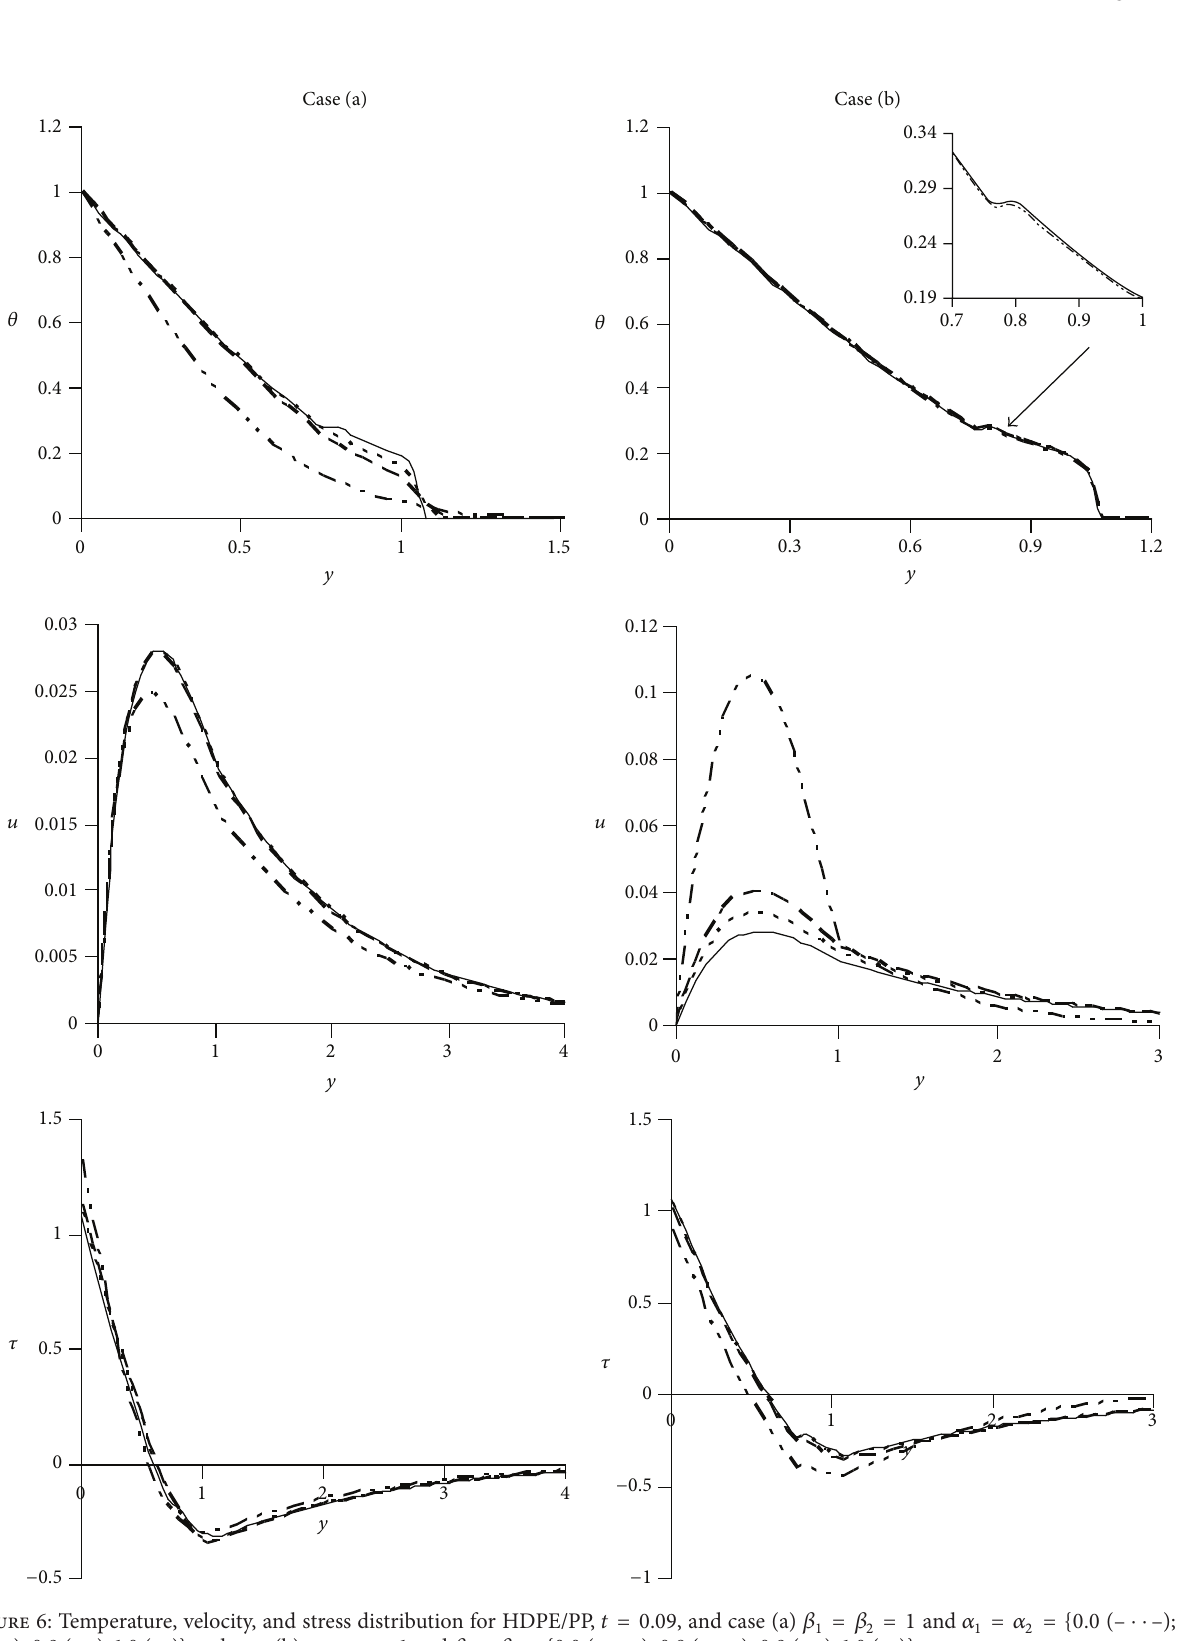
Figure 6: Temperature, velocity, and stress distribution for HDPE/PP, 𝑡 = 0.09 , and case (a) 𝛽 1 = 𝛽 2 = 1 and 𝛼 1 = 𝛼 2 = { 0.0 (– ⋅ ⋅ –); 0.8 (–– –); 0.9 ( ⋅ ⋅ ⋅ ); 1.0 (— )} and case (b) 𝛼 1 = 𝛼 2 = 1 and 𝛽 1 = 𝛽 2 = { 0.0 (– ⋅ ⋅ –); 0.8 (–––); 0.9 ( ⋅ ⋅ ⋅ ); 1.0 (— )}